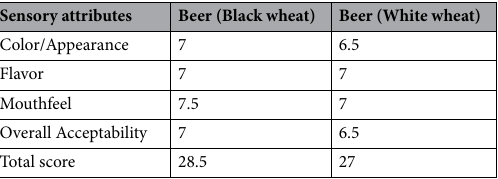
Table 3. Sensory scores of beer produced from black wheat and control white